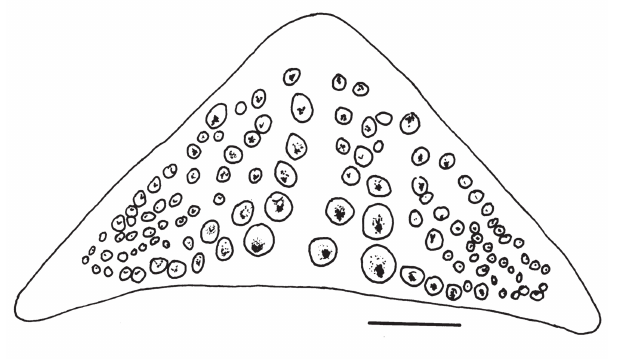
Fig. 3 . Crenicichla hadrostigma , lower pharyngeal tooth plate in occlusal view, MCP 22036 (92.5 mm SL, female). Scale bar: 1mm.